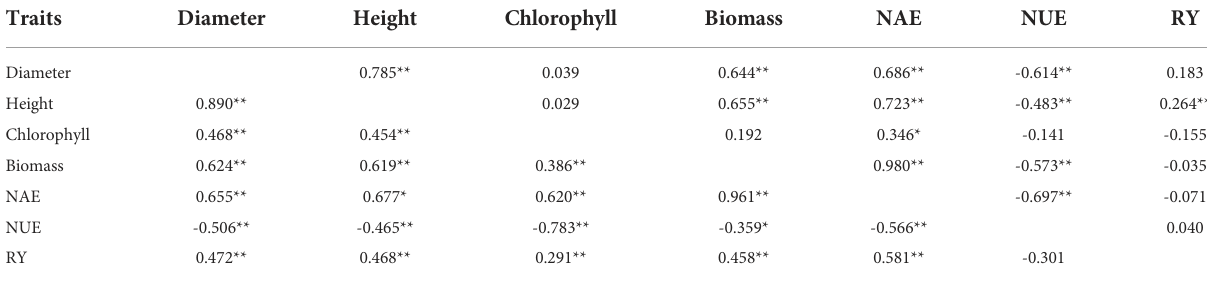
**and*indicated thesigni fi cantlevel p<0.01and0.05,respectively. NAE,NUE,andRYrepresented nitrogenabsorptionef fi ciency, nitrogen useef fi ciency, andrelative